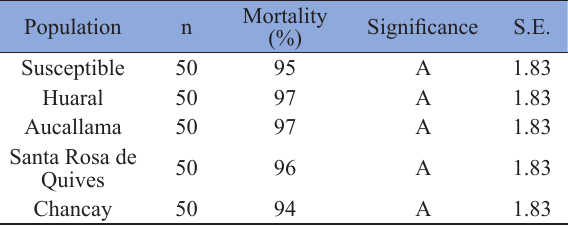
Table 5: Mortality (%) of four field populations of T. urticae due to LC95 of Spirodiclofen (0.1008 mL.L−1) obtained for the susceptible reference